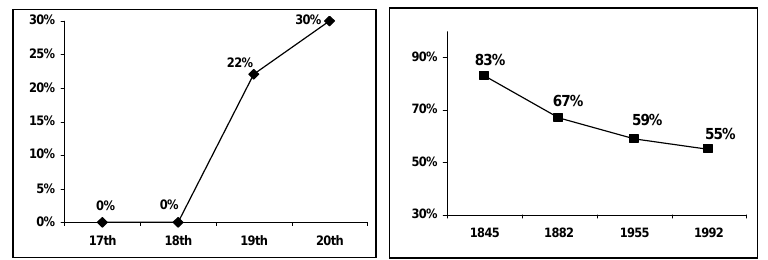
Figure 7- Frequency of existential ter (as compared to the frequency of haver ) in documents written in Brazil, from the 17 th century to the 20 th century (Avelar 2005; Callou & Avelar, 2002)